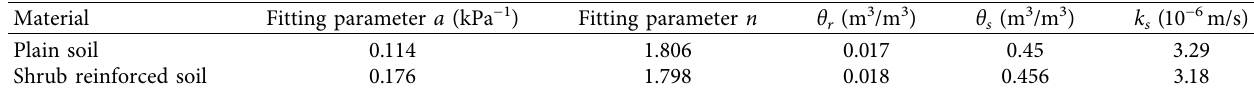
Table 2: Hydraulic characteristic parameters of the